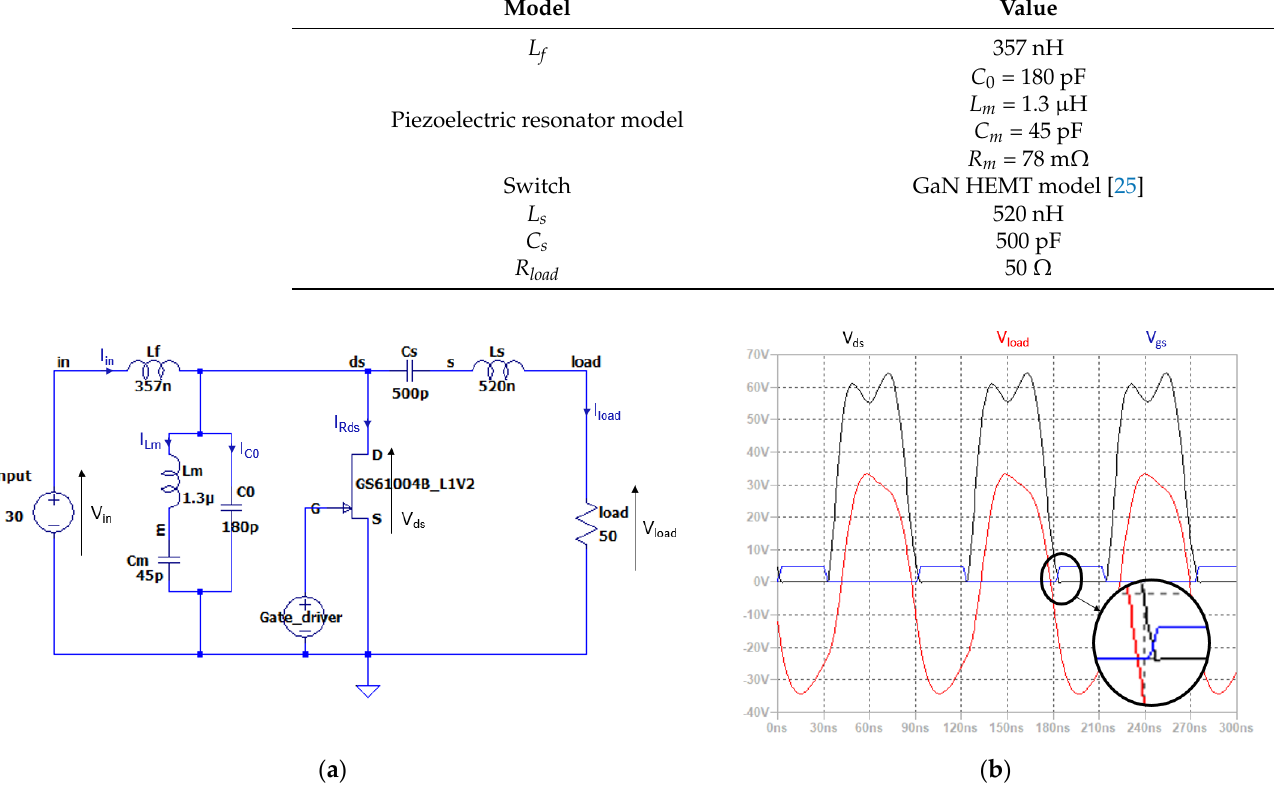
Figure 7. LTspice simulation model of the L − Piezo inverter ( a ), and main voltages waveforms of the class L − Piezo inverter ( b ).